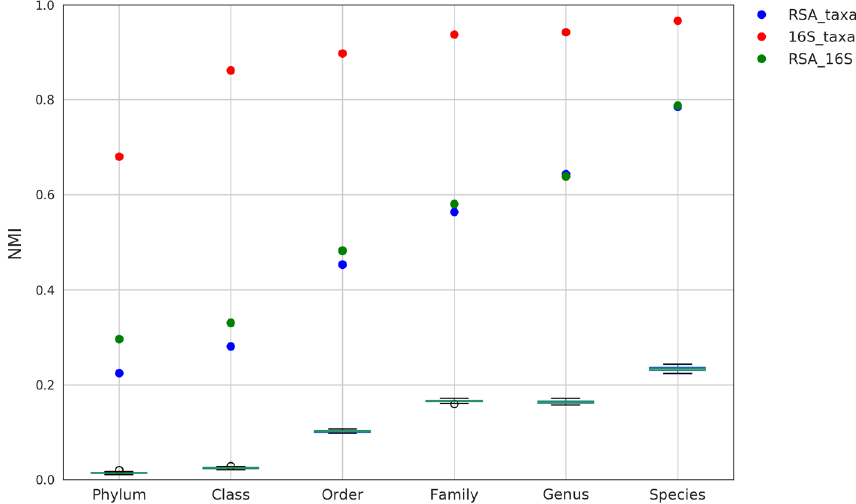
Figure 3. Comparison between the three clustering results at different taxonomic levels. NMI scores ( y-axis ) are calculated as a measurement of agreement between clusters based on: RSA method and taxonomy ( blue ), 16S rRNA gene and taxonomy ( red ), RSA method and 16S rRNA gene ( green ). Different taxonomic levels are considered for the comparison: phylum, class, order, family, genus and species ( x-axis ). The box plots represent the baselines of NMI score and are based on